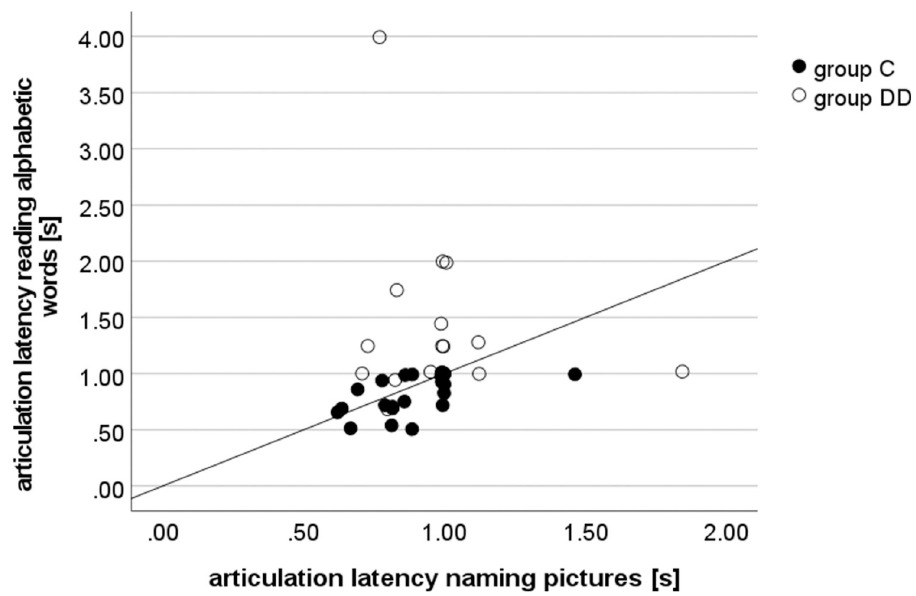
Fig 7. Correlation between articulation latency for pictures (abscissa) vs. alphabetic words (ordinate). For pictures, the articulation latencies are widely overlapping between the groups. For alphabetic words, the groups are to a great extend separated. Group DD is slower in word reading. Shorter articulation latencies for words than for pictures are found mainly in group C. Positive statistically significant correlation for group C: Spearman’s Rho, r p = .002; no statistically significant correlation for the children with dyslexia: Spearman’s Rho, r s (16) = .051, p = .842.